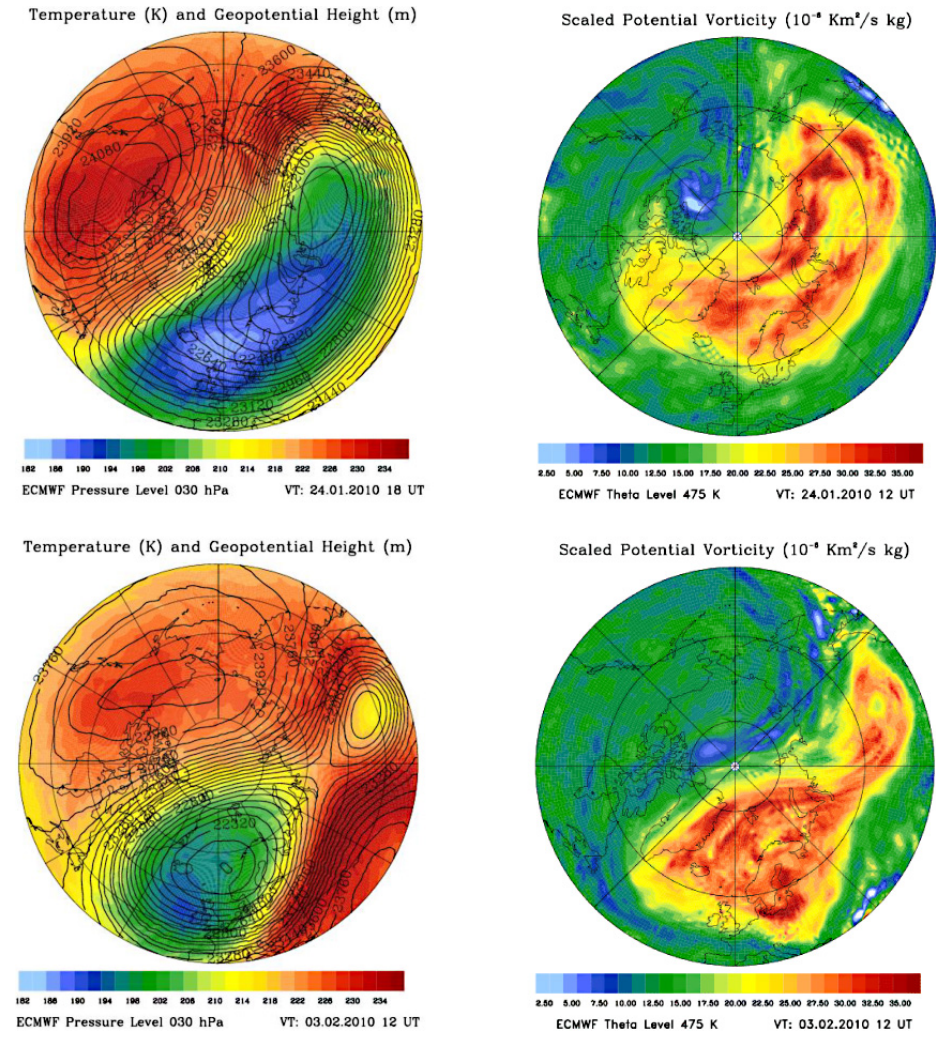
Fig. 6. left: absolute Temperature (K, colour shaded) and geopotential height (m; black contour lines) at the 30 hPa pressure surface. Right: Scaled or modified potential vorticity PV · (2 /420K) − 9 / 2 (PVU; colour shaded) at 2 =475K . Operational ECMWF T1279/L91 analyses interpolated at a regular 0.5 ◦ × 0.5 ◦ latitude/longitude